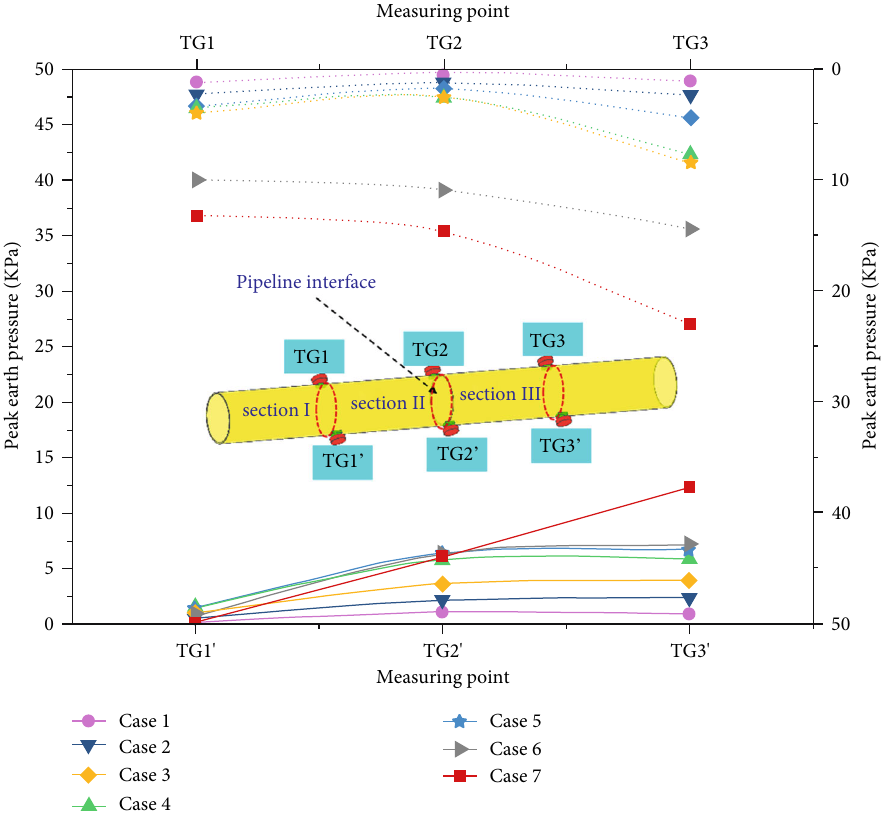
Figure 13: Earth pressure distribution in front and back of